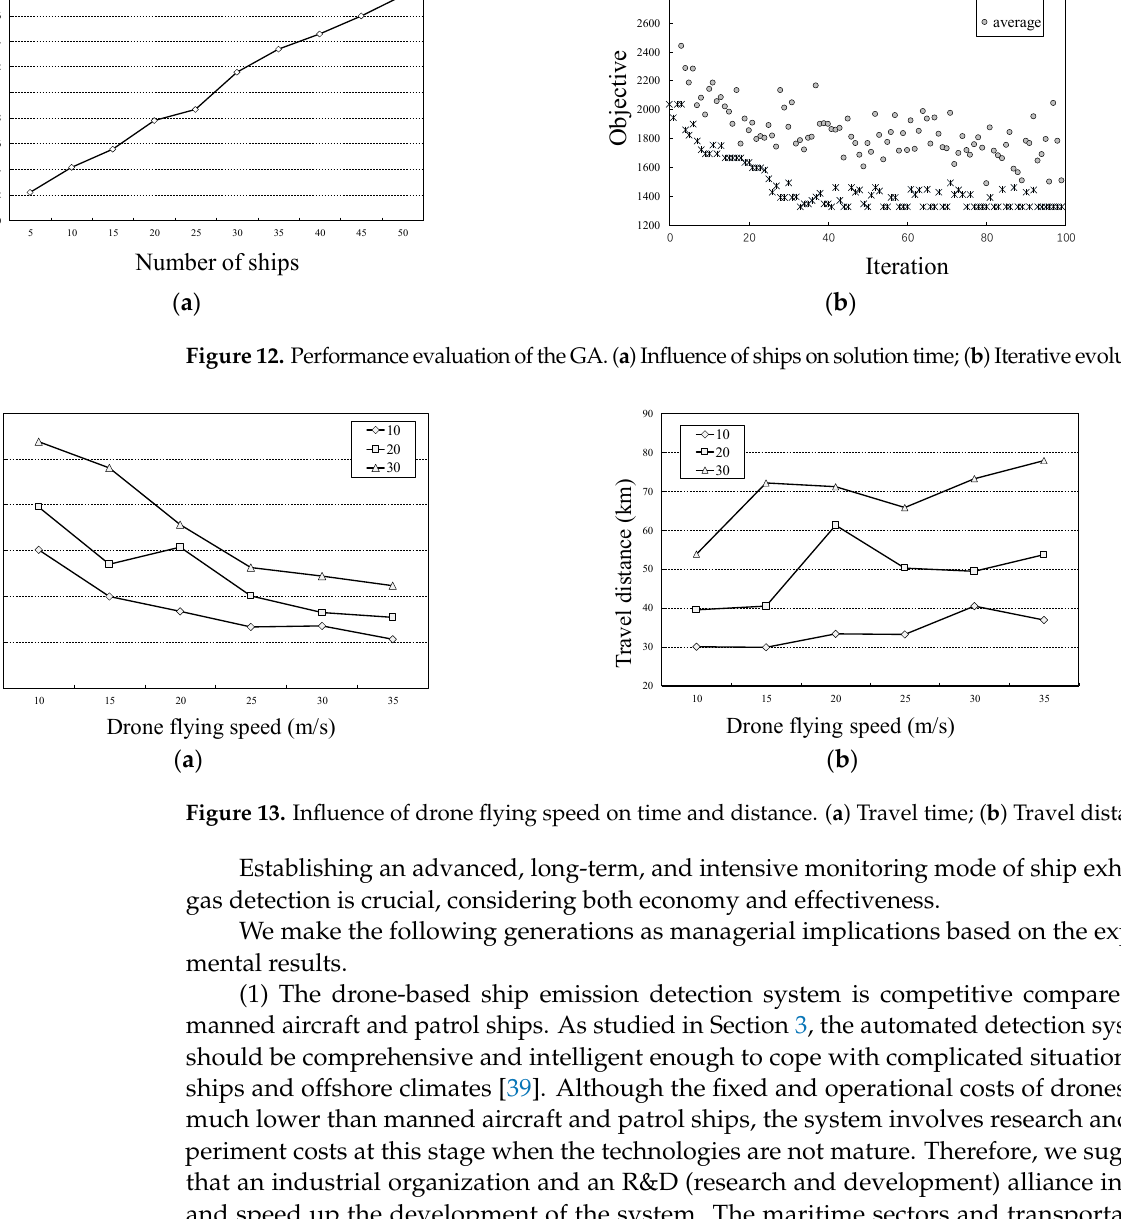
Figure 13. Influence of drone flying speed on time and distance. ( a ) Travel time; ( b ) Travel dis- tance.